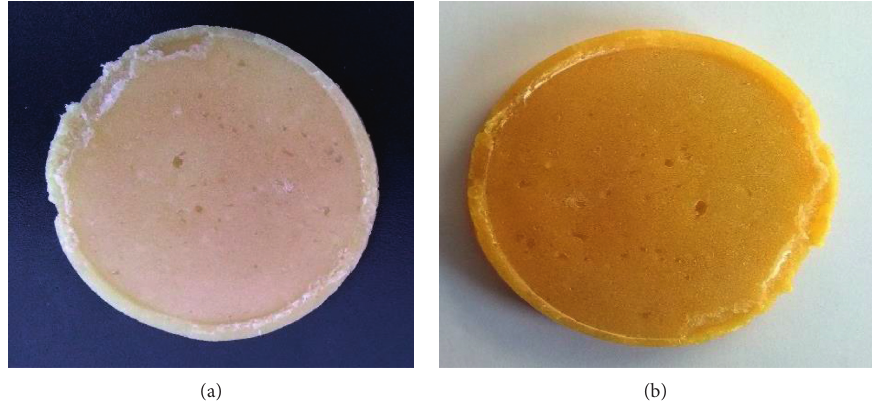
Figure 5: The images of the PEG adhesive film before (a) and after (b) storage.